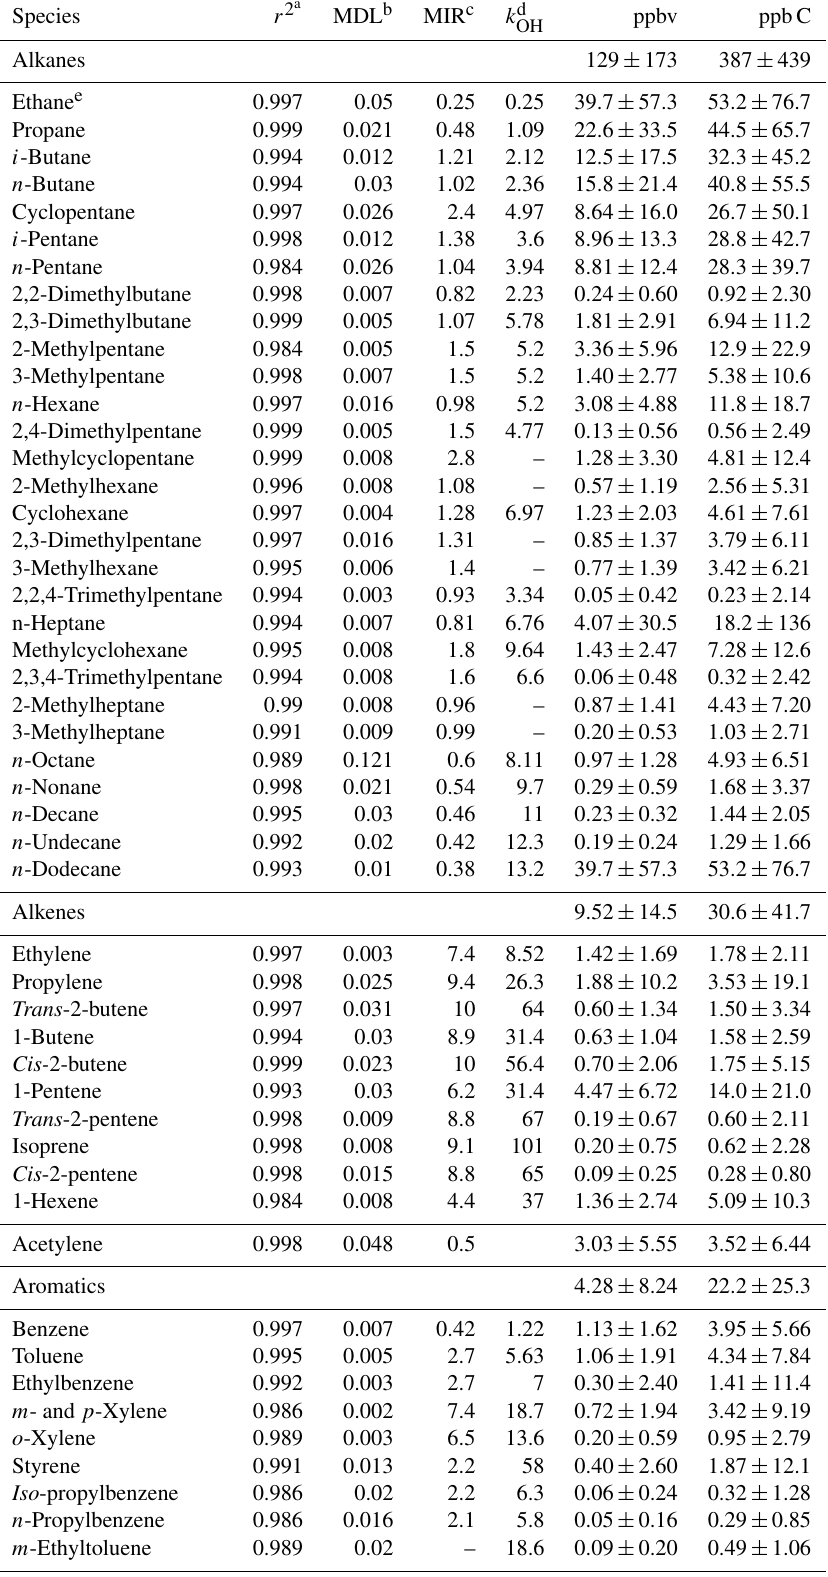
Table 1. Concentrations (mean ± standard deviation) during the sampling period and the photochemical properties of VOCs. Species r 2